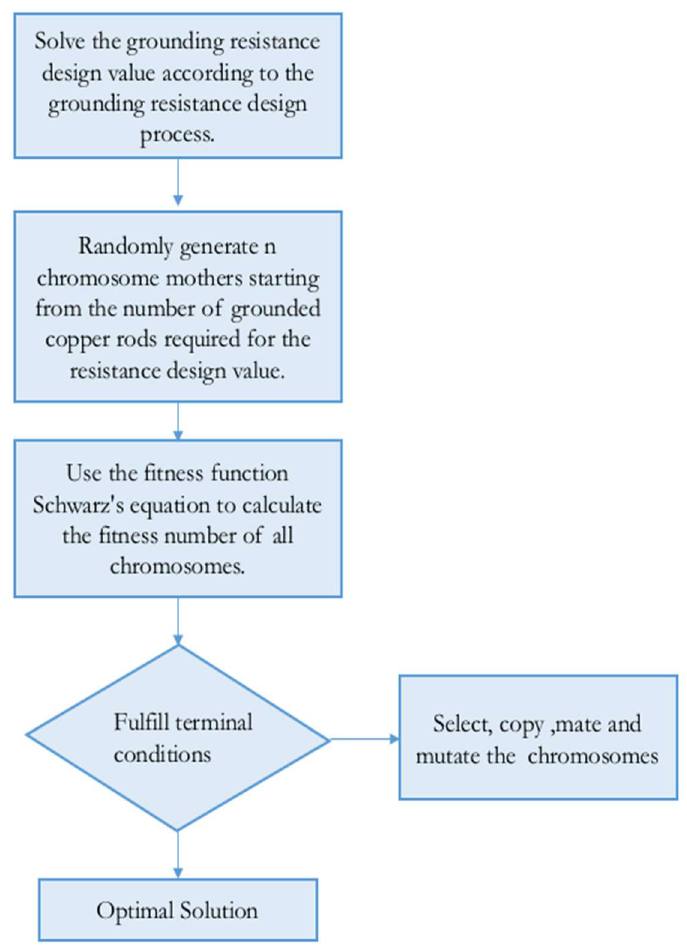
Figure 3. Flow of the grounding system with GAO.